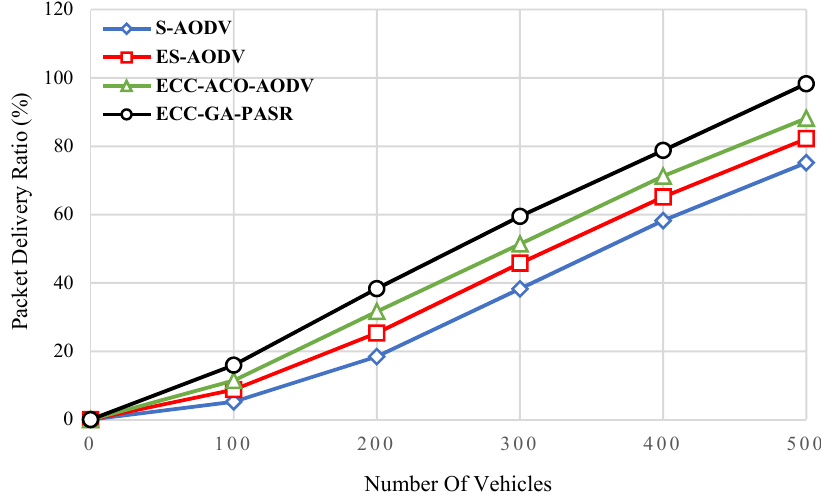
Figure 10. PDR Calculation based on number of vehicles.